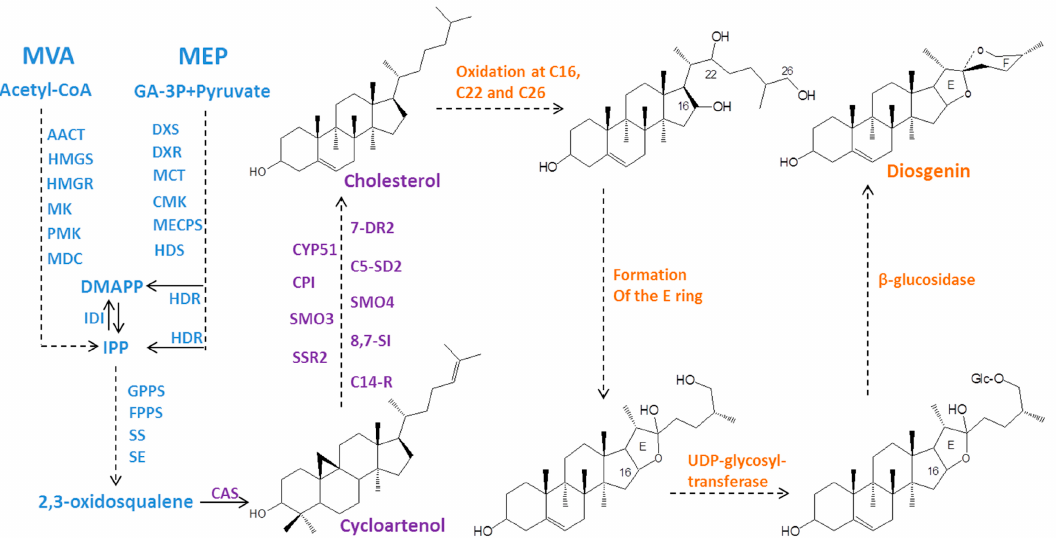
Scheme 1. Proposed diosgenin biosynthetic pathway. Abbreviations: GA-3P, D -Glyceraldehyde 3-phosphate; DXP: 1-Deoxy- D -xylulose-5-phosphate; MEP, 2-C-Methyl- D -erythritol-4-phoshate;